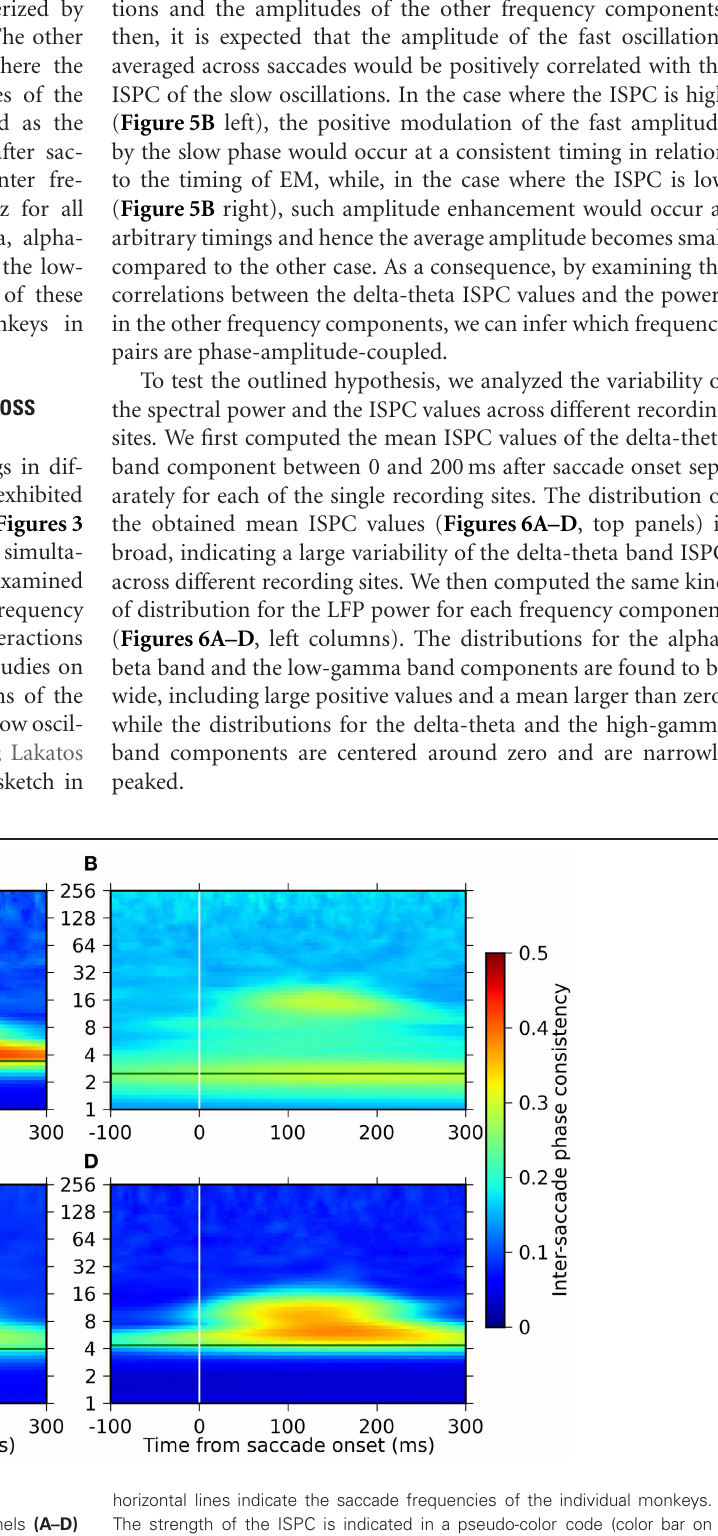
horizontal lines indicate the saccade frequencies of the individual monkeys. The strength of the ISPC is indicated in a pseudo-color code (color bar on the